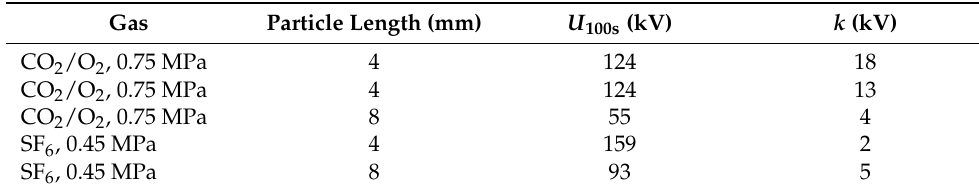
Table 1. U 100s and k values for the tests with a single free particle in set-up 2.